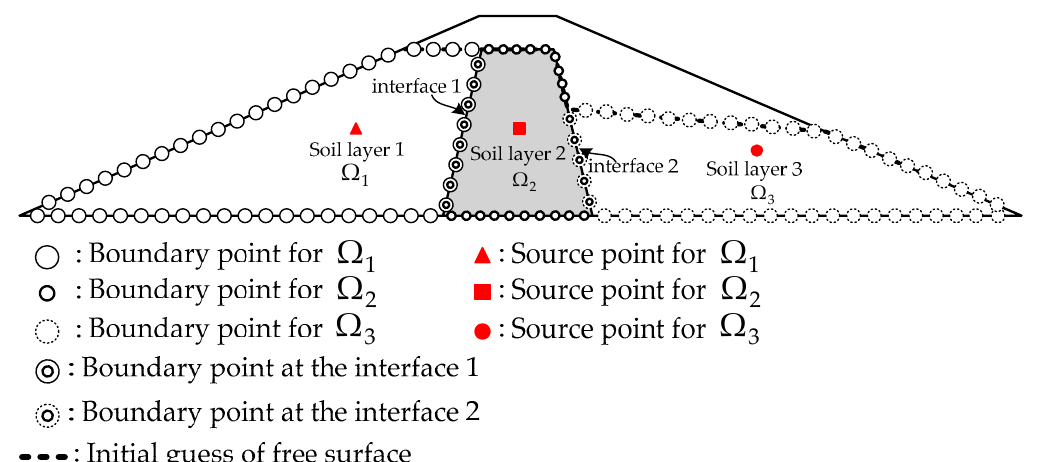
Figure 13. The collocation scheme of the zoned-earth dam for the DDM.